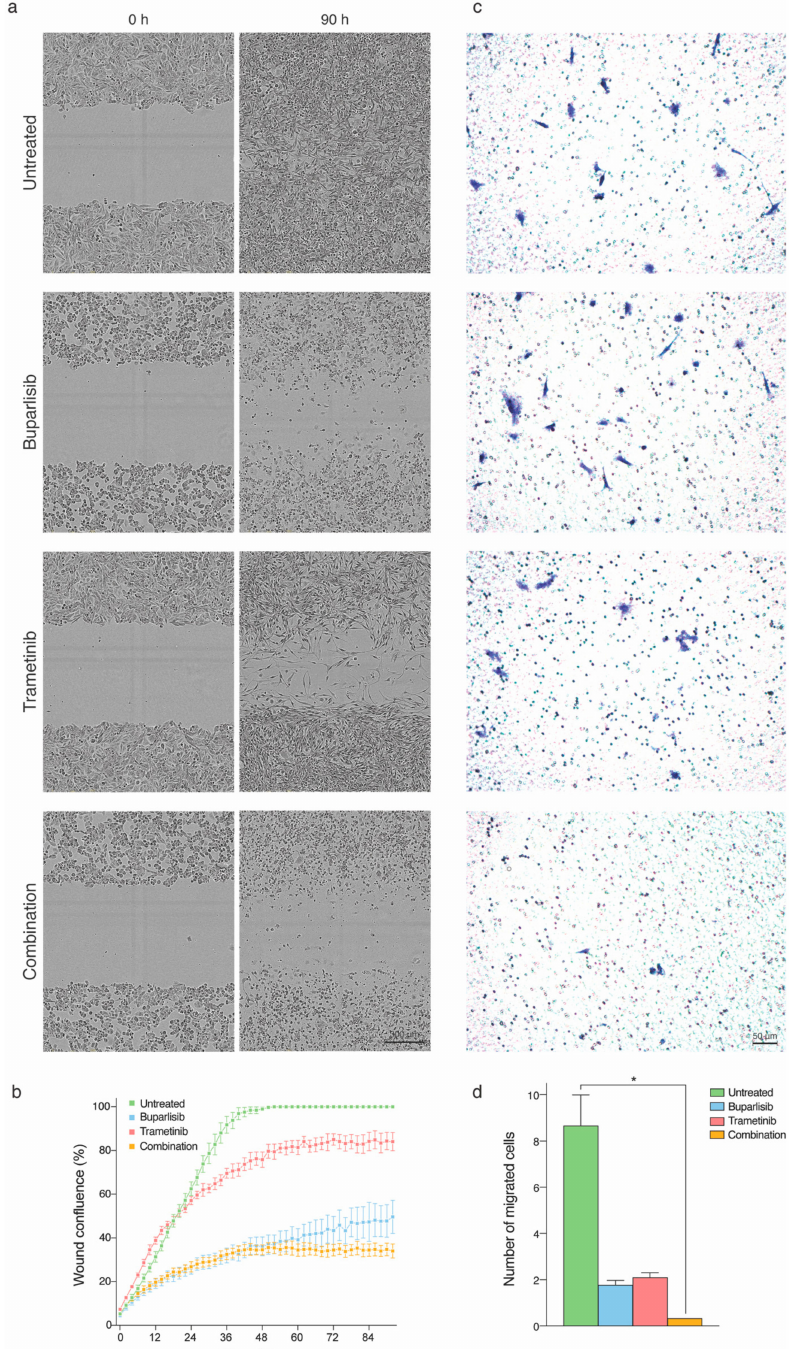
Figure 4. Migration of H1 cells during and after pre-treatment with 10 µ M buparlisib, 10 µ M trametinib or a combination (5 µ M buparlisib + 5 µ M trametinib). ( a ) representative micrographs of H1 cells